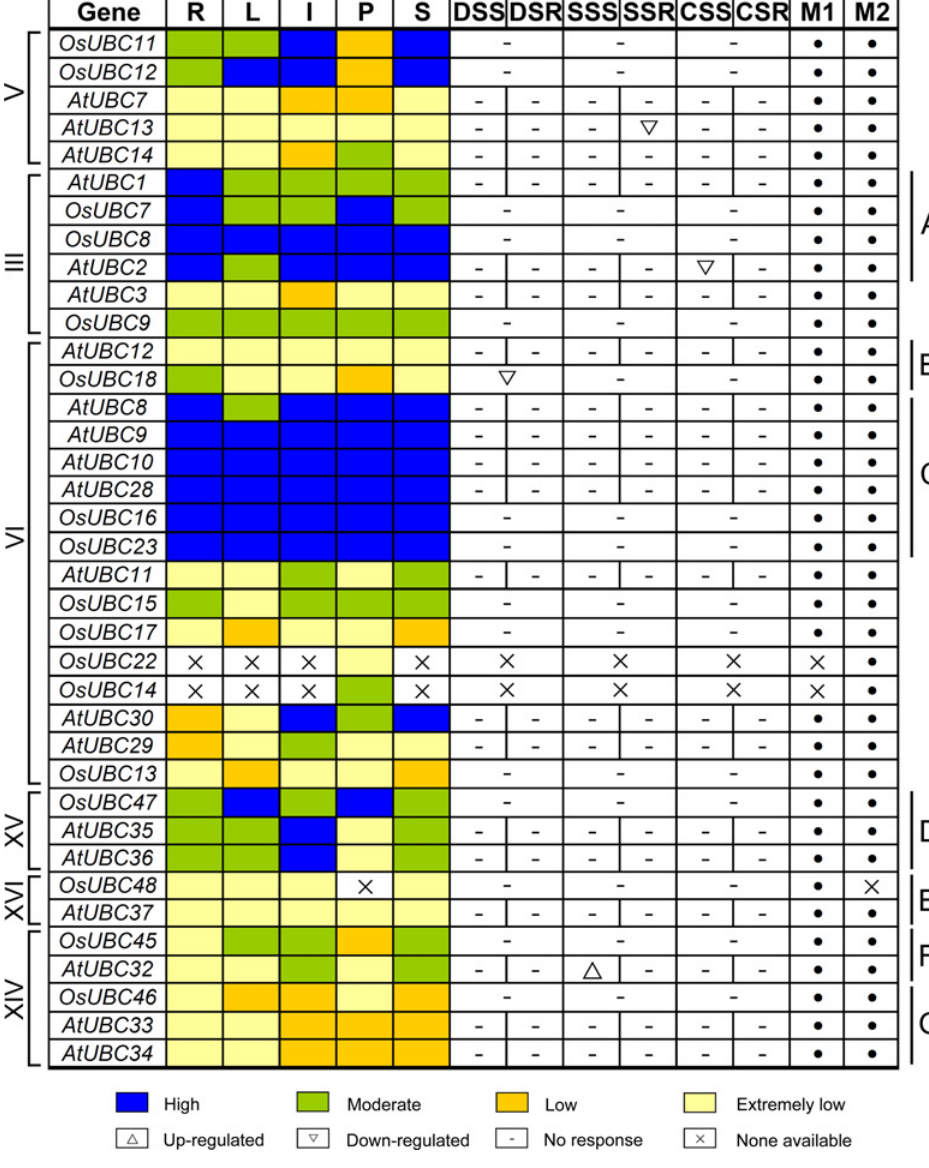
Fig 8. Expression comparison between rice and Arabidopsis UBC genes in different organs and under abiotic stresses. The OsUBC and AtUBC genes in subfamilies V, III, VI, XV, XVI and XIV are displayed according to the order in the corresponding phylogenetic tree (S2 Fig). The expression data of OsUBC genes in different organs are combined from microarray and MPSS tags represented by M1 and M2, respectively. The expression data in pollens of OsUBC genes were extracted from MPSS tags. The ratios of the absolute values divided by the average of all microarray values were used for analysis (S4 Table). Blue, green, yellow and light yellow boxes indicate high (more than 2 or more than 300 tpm), moderate (between 1 and 2 or between 50 and 300 tpm), low (between 0.5 and 1 or the signature numbers between 0 and 50 tpm), and extremely low (less than 0.5 or no signature is found) expression levels, respectively. R, root; L, leaf; I, inflorescence; P, pollen; S, silique or seed; DSS and DSR; drought stressed shoot and root; SSS and SSR, salt stressed shoot and root; CSS and CSR, cold stressed shoot and